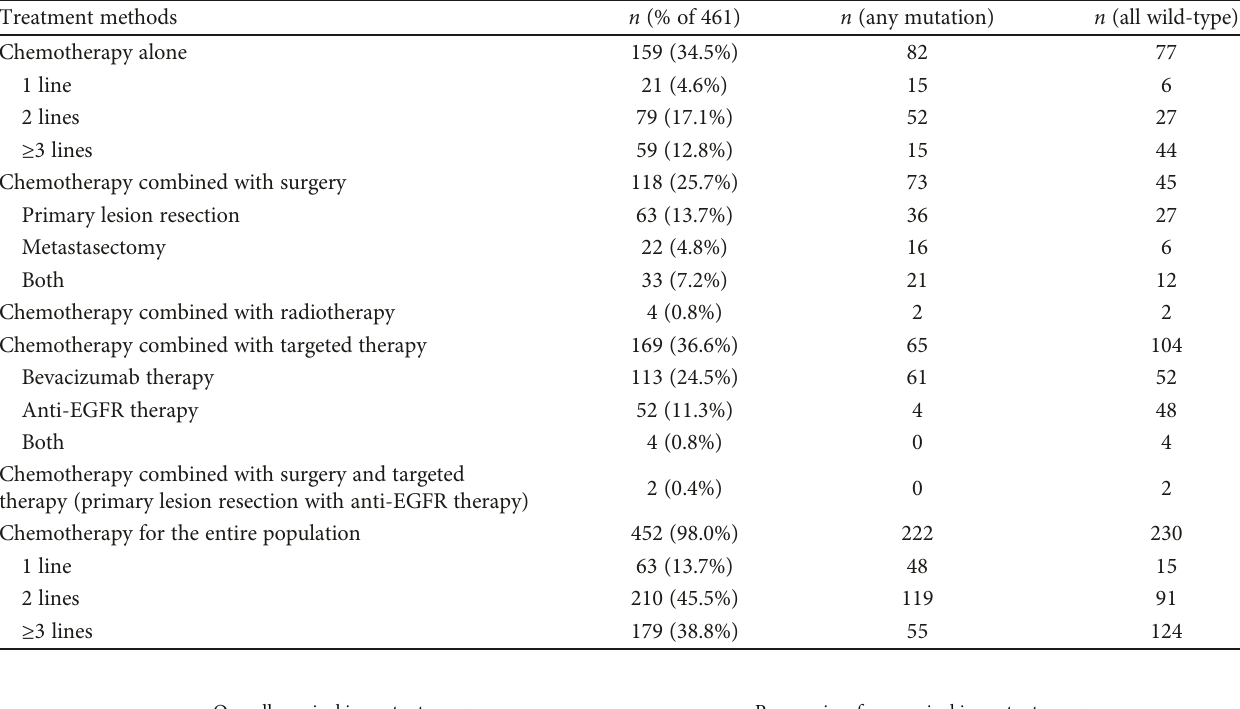
Table 5: Treatment details of metastatic colorectal cancer patients.